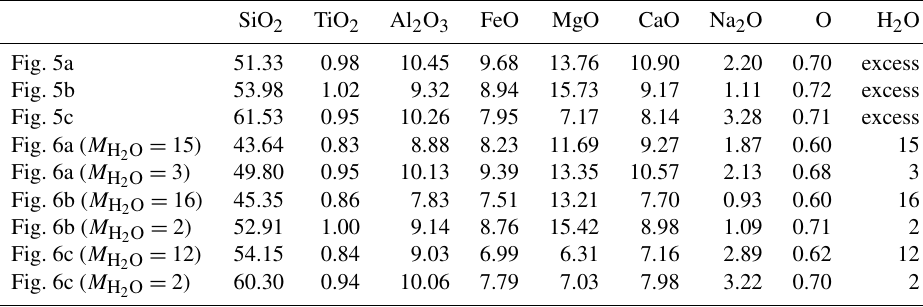
Table 2. Bulk compositions (in mole %) used to construct the